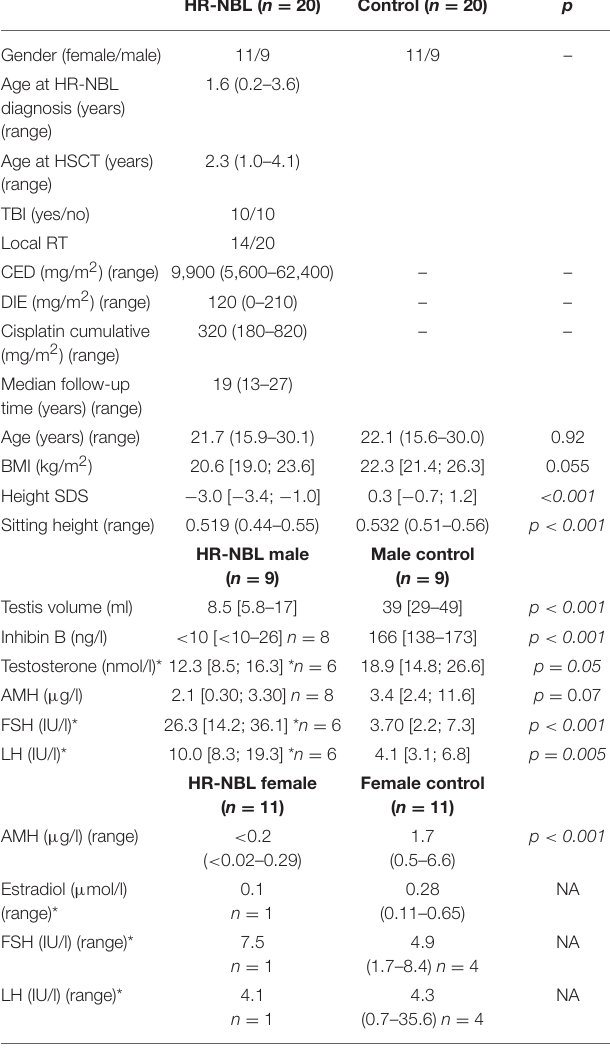
TABLE 1 | Clinical and treatment characteristics, and gonadal hormone concentrations [median [interquartile range] or (range)] in the survivors of high-risk neuroblastoma (HR-NBL; n = 20), and their healthy controls ( n =